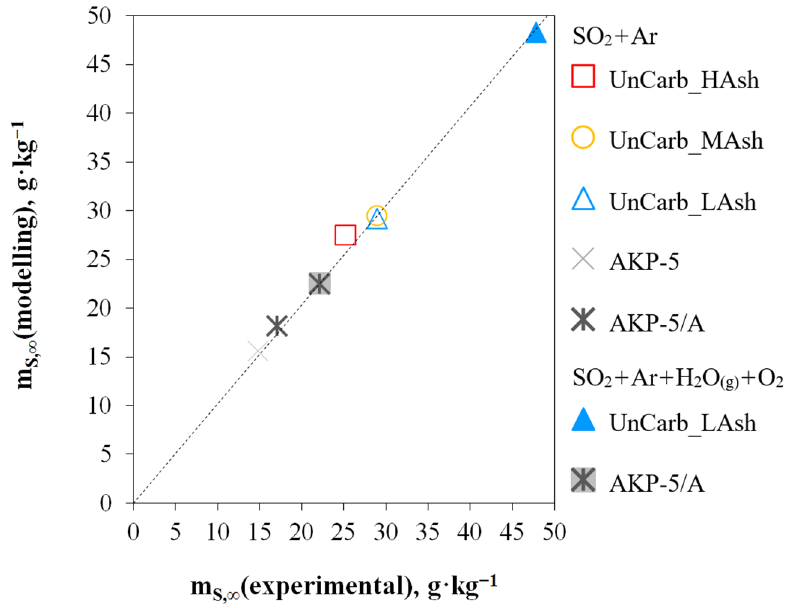
Figure 3. Relationship between the model and experimental amount of bound adsorbate.